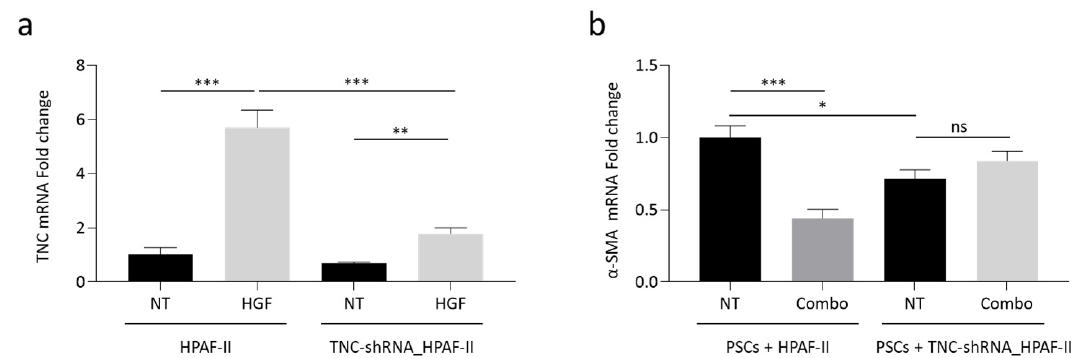
Figure 6. Knocking-down of TNC expression blunts MET-mediated stromal activation. ( a ) TNC-specific qRT-PCR analysis of mRNA derived from HPAF-II cells (wild-type or genetically engineered to express TNC-shRNAs) treated with HGF. Data are expressed as fold-change values relative to the untreated control (wild-type HPAF-II). ( b ) α -SMA-specific qRT-PCR analysis of mRNA derived from human PSCs co-cultured with HPAF-II wild-type or genetically engineered to express TNC-shRNAs, treated with MvDN30 and decoyMET K842E in combination (Combo). Data are expressed as fold-change values relative to untreated control (PSCs co-cultured with wild-type HPAF-II). NT, untreated controls. Each bar represents the average value ± SD. Student’s t test: *, p ≤ 0.05; **, p ≤ 0.01; ***, p ≤ 0.001; ns, not significant. Data reported in figure are representative of at least two independent